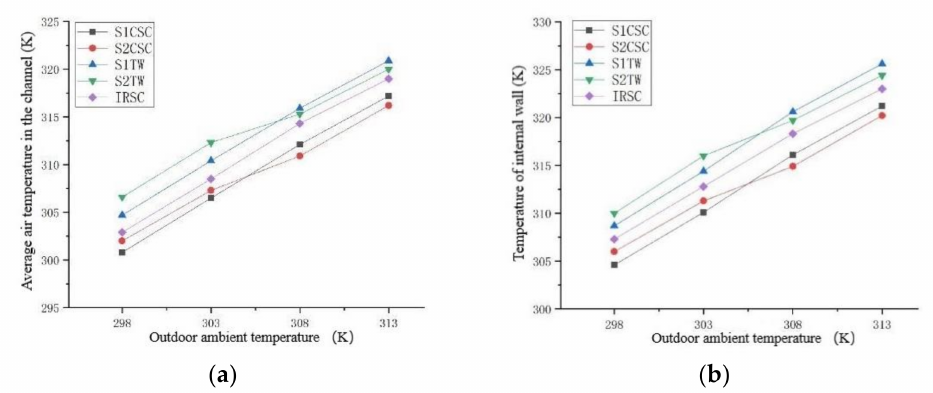
Figure 5. The temperatures of the thermal gap and interior wall at different ambient temperatures: ( a ) average temperature of the air channel and ( b ) the temperature of the internal